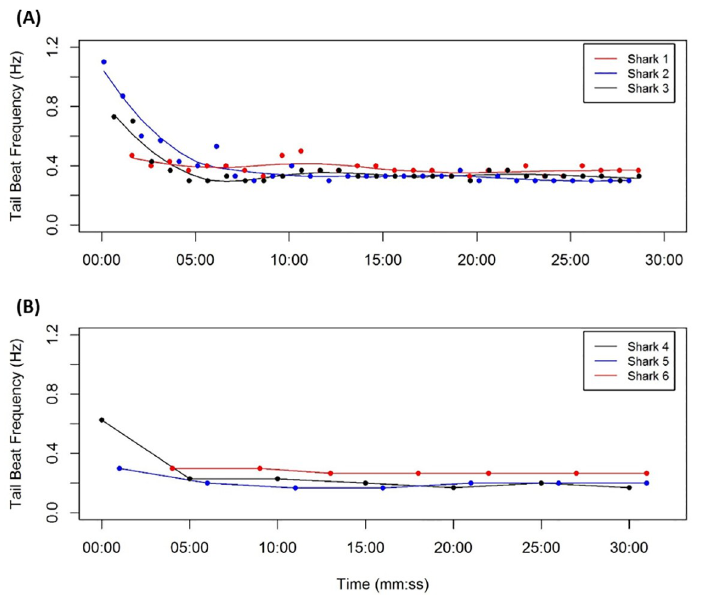
Fig 2. Response to tagging. ( A ) Tail beat frequency in response to tagging calculated from 30 second segments of video data taken every minute for first 30 minutes of video data (uses continuously recorded data gathered in 2018 only). ( B ) Tail beat frequency calculated for each 30 second recording period every 5 minutes (for 30 minutes) for duty cycled camera tags deployed in 2019. Local order regression smoothing (colour lines; 0.5 span). rate of turning indicated that there was considerable variation in the response of individual sharks to tagging (Fig 2). Shark 2 displayed the highest TBF within the first 5 minutes following tagging (1.1 Hz) before stabilising at 0.3 Hz. Shark 1 maintained the highest TBF over the 30 minute period (0.4 Hz) whereas shark 5 revealed the weakest response (0.2 Hz). Vertical movement Depth use varied between sharks, and between years (Fig 3). In 2018, sharks 1, 2 and 3 spent less than 1% of time swimming within a metre of the surface (0.15%, 0.38% and 0.13% of time respectively), while in 2019, sharks 4, 5 and 6 spent longer at the surface (49%, 30% and 15% respectively). Sharks tagged in 2018 swam at greater depth than those tagged in 2019 (mean in 2018 25.6 m ± 13.6, versus mean in 2019 13.6 m ± 3.5), with a maximum depth of 131 m recorded by shark 1. Sharks 1, 2 and 3 were in proximity to the seabed (seabed visible within video; e.g. Fig 3A–3C) for nearly half of the camera operation period (57%, 47% and 42% respectively of the duty cycled data, vs 61%, 48% and 48% respectively in the continuous data). When restricted to daylight hours, during which the vertical position of the shark in the water column could be characterised, sharks 1 to 3 were in proximity to the seabed 57%, 81% and 88% of camera recording time (in the duty cycled data, similar to the continuous data 61%, 82% and 92% respectively, Fig 3A–3C). Shark 1 made repeated short ascents to the surface before returning to 50 to 60 m depth where no behaviour could be inferred from the video data due to insufficient ambient light, whereas sharks 2 and 3 remained predominantly within the upper 30 m of the water column. Comparatively, sharks 4, 5 and 6 spent less than 20% of their camera recording duration near to the seafloor. These three sharks switched between intermittent surface swimming to repeated dives between the surface and the seafloor (“yo-yo” dives), interspersed with excursions to the seafloor (Fig 3D and 3E).